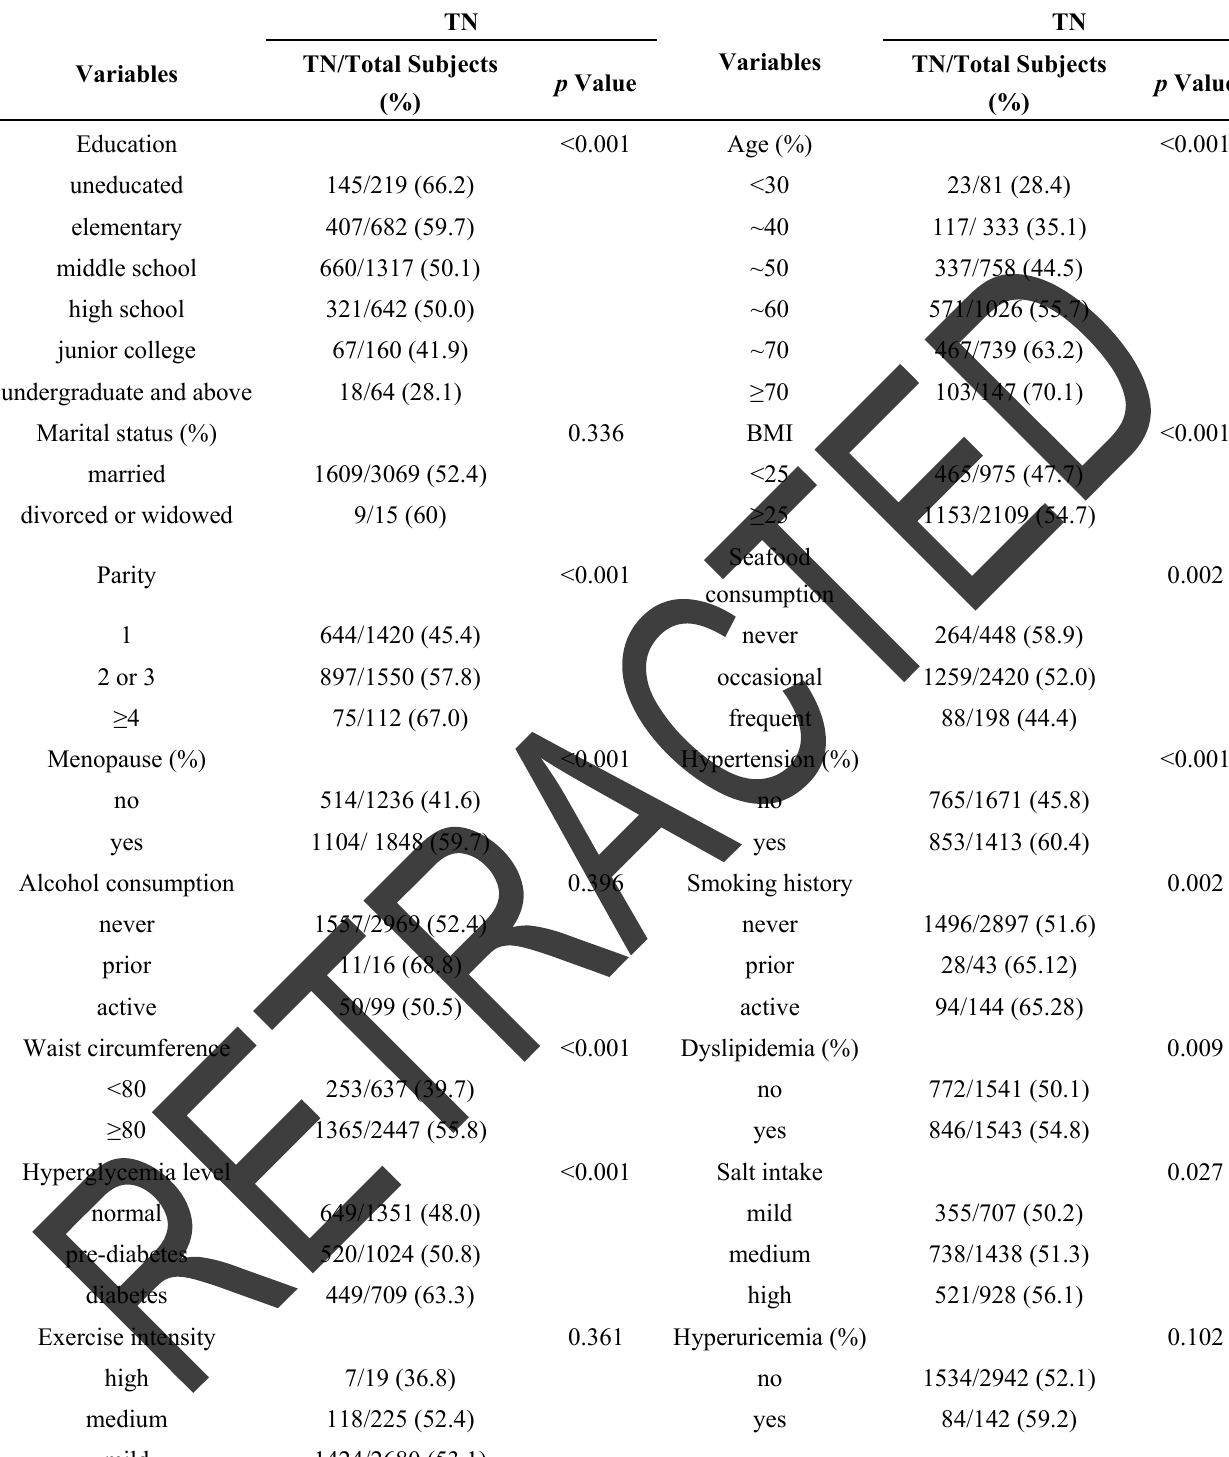
Table 1. Characteristics of the study population and